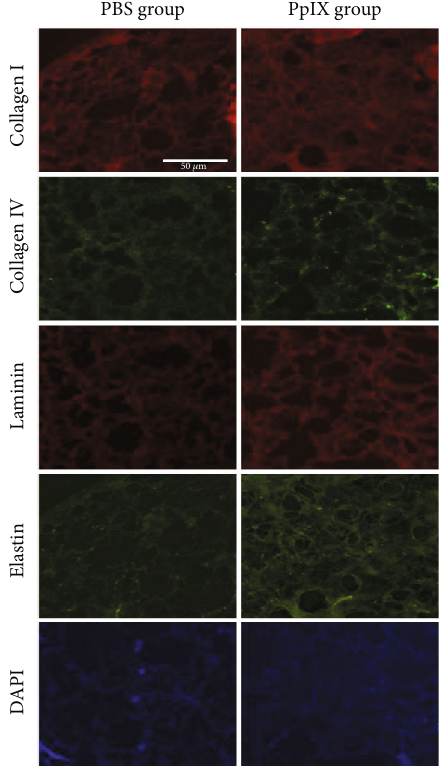
Figure 5: Immuno fl uorescent images of extracellular matrix components of acellular lung sections of the control group and the protoporphyrin IX group after LED